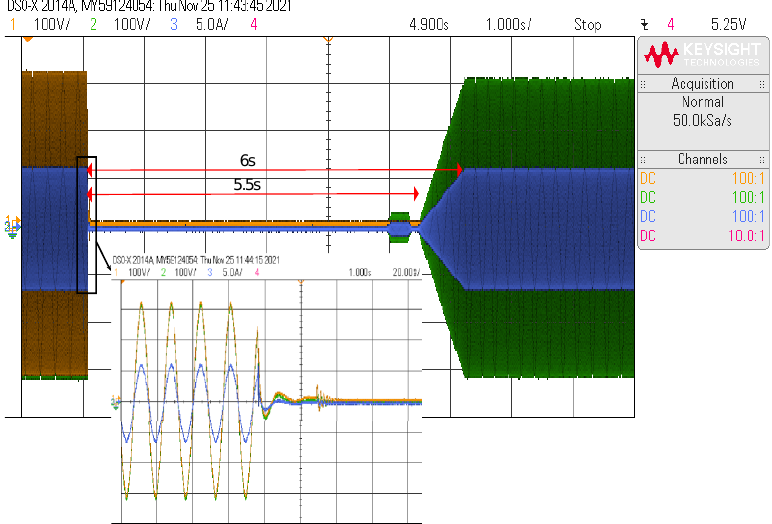
Figure 12. Transitioning from grid-connected to islanded MG mode: grid voltage (yellow), inverter output voltage (green) and load current (blue).